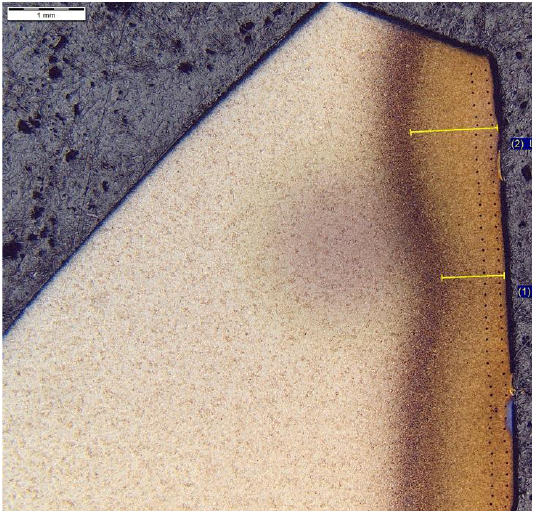
Figure 10. Microhardness measurement results. Paths depth (distance from tooth surface): 0.1 mm and 0.3 mm. Cross-section F-F, zone: 3A.